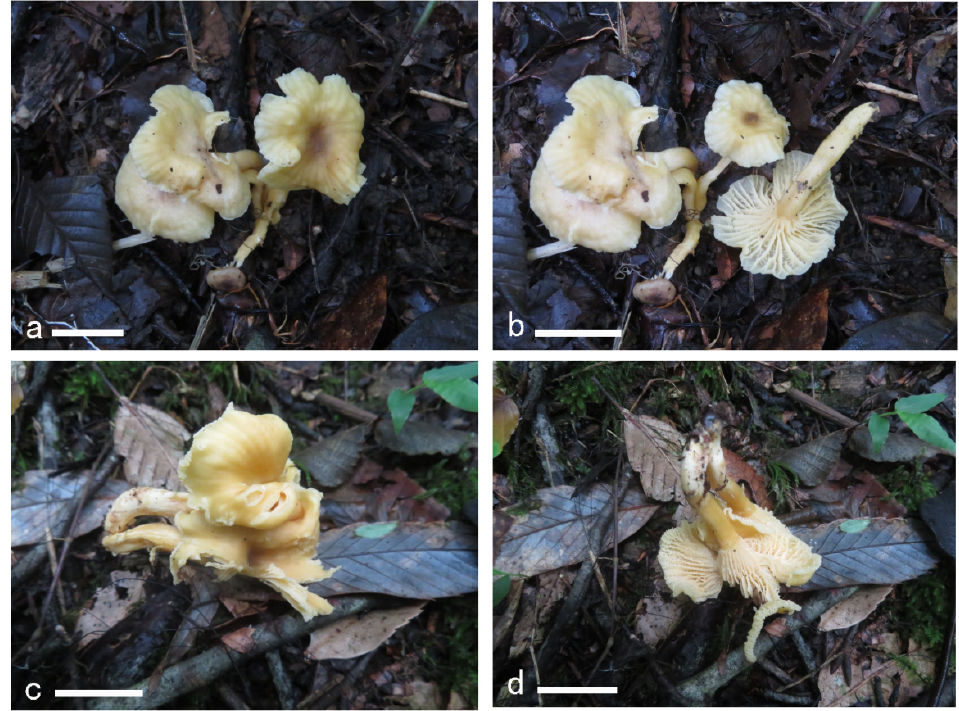
Figure 16. Basidiomata of Cantharellus koreanus. ( a,b ) GDGM79233. ( c,d ) GDGM85306. Bars = 2 cm.